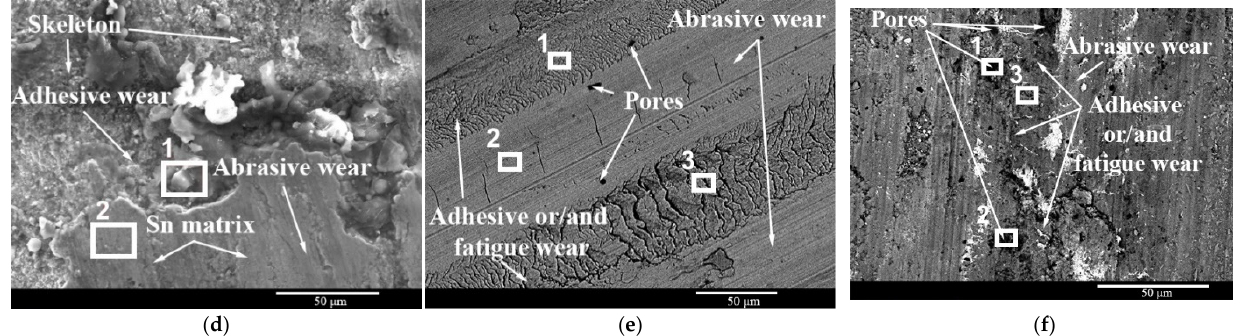
Figure 4. SEM images with marks highlighting different zones of EDS analysis of the following samples: ( a ) wear surface of B83 babbitt at a load of 40 N; ( b ) wear surface of hybrid material at a load of 40 N; ( c ) wear surface of B83 babbitt at a load of 50 N, after ref. [32] (adapted from [32], with permission from Springer Nature 2020); ( d ) wear surface of hybrid material at a load of 50 N, after ref. [32] (adapted from [32], with permission from Springer Nature 2020); ( e ) wear surface of B83 babbitt at a load of 60 N; ( f ) wear surface of hybrid material at a load of 60 N.